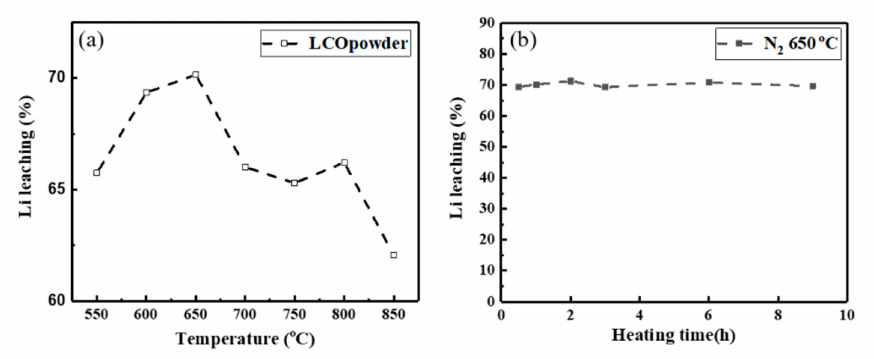
Figure 6. Leaching result after heat treatment by ( a ) temperature and ( b ) time in nitrogen